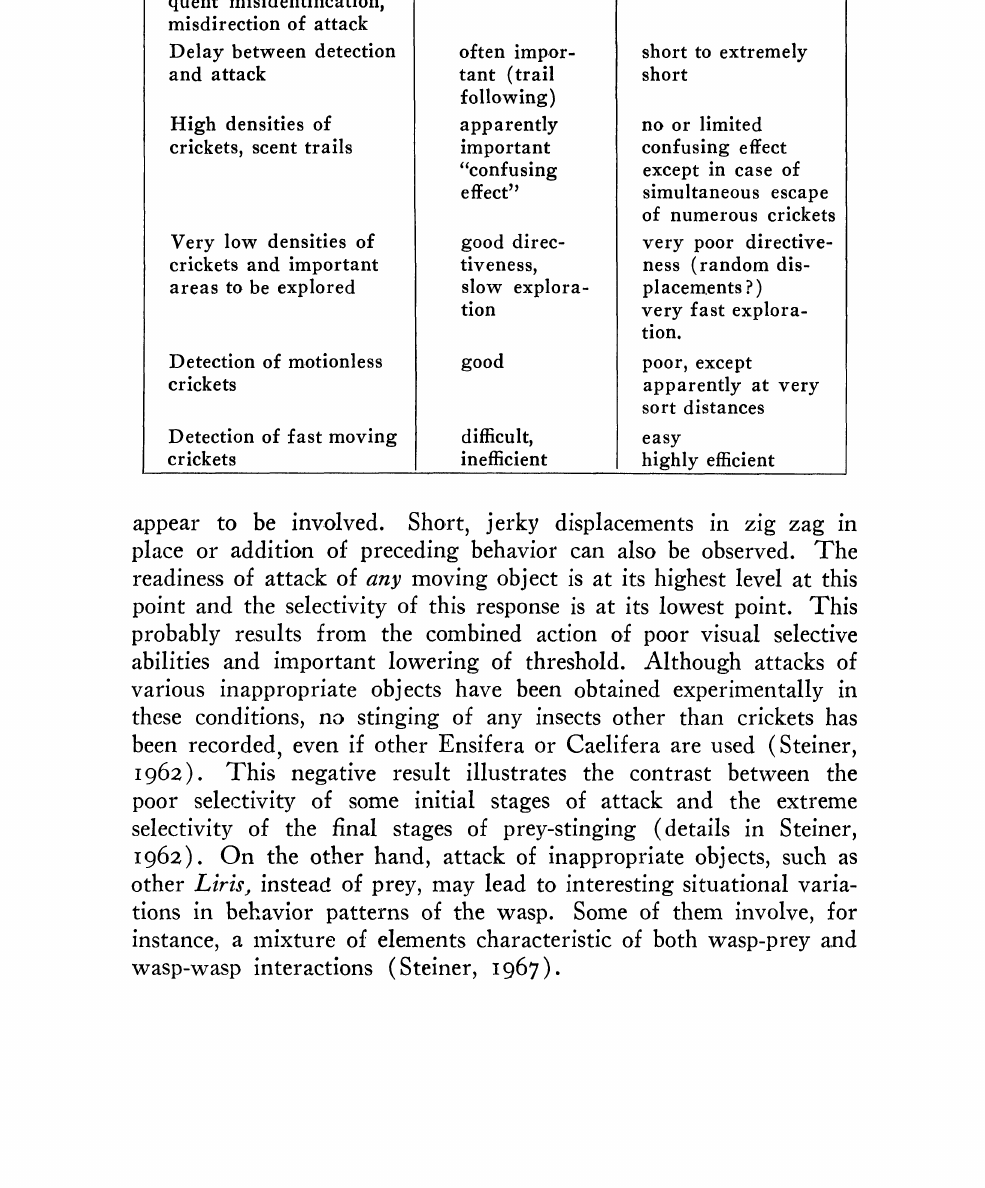
Table 2. Comparison of characteristics of prey-detection by scent and by sight. Characteristics